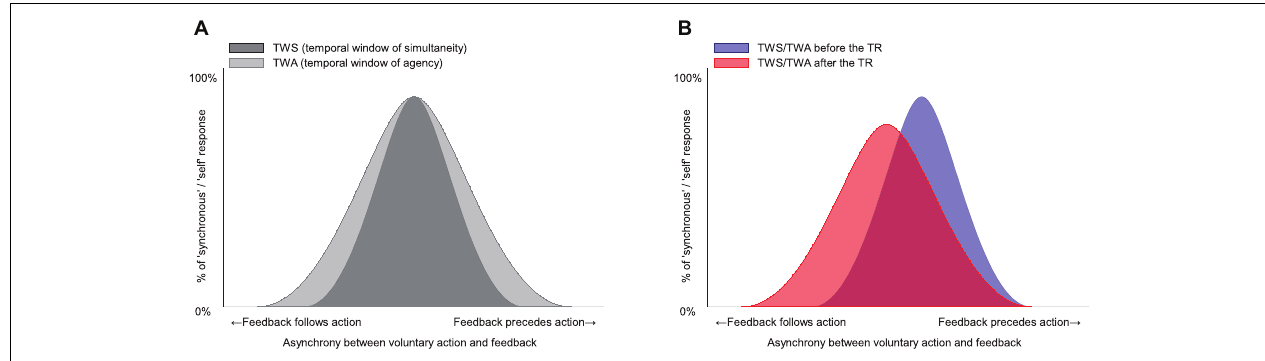
FIGURE 2 | The model and the predictions about a change in sense of agency (SoA) after temporal recalibration (TR). (A) Hypothetical temporal window of simultaneity (TWS) and of agency (TWA) between voluntary action and sensory feedback. Note that the width of TWA is wider than the width of TWS. (B) The TR might modulate a midpoint and/or a width of the TWS and